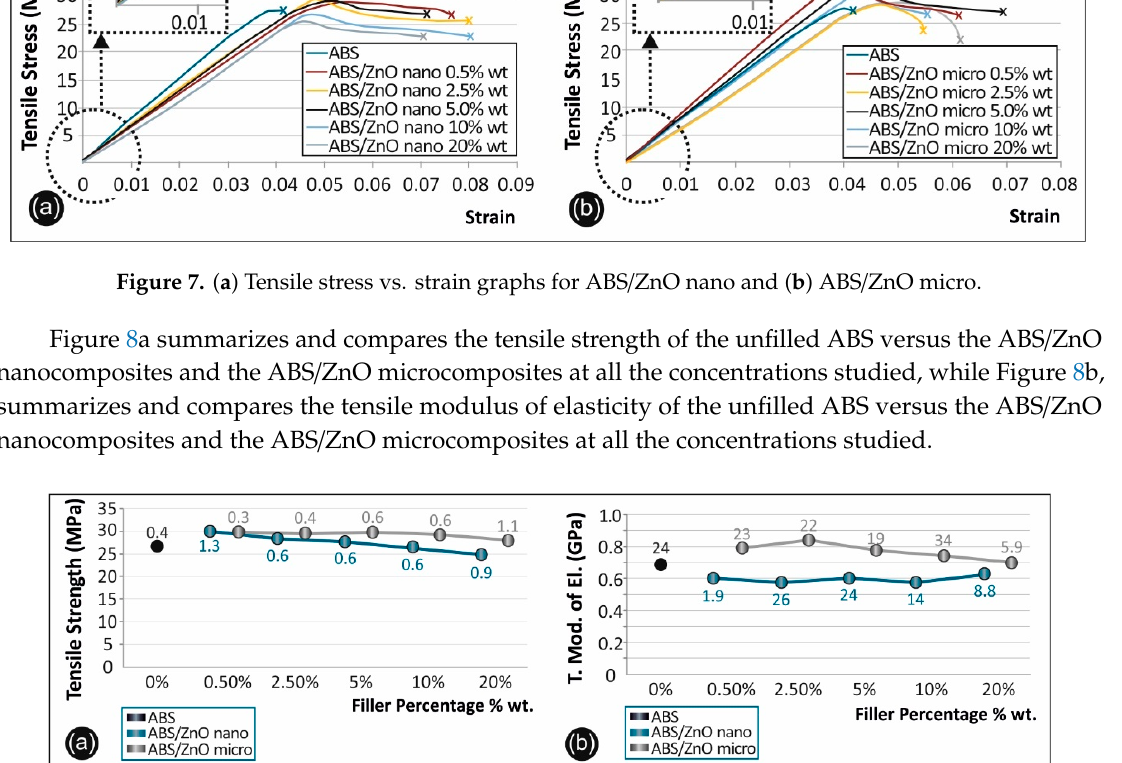
Figure 8. ( a ) Comparative tensile strength graph and ( b ) tensile mod. of elasticity for all the materials studied (numbers in the graph points indicate the calculated deviation for each value).